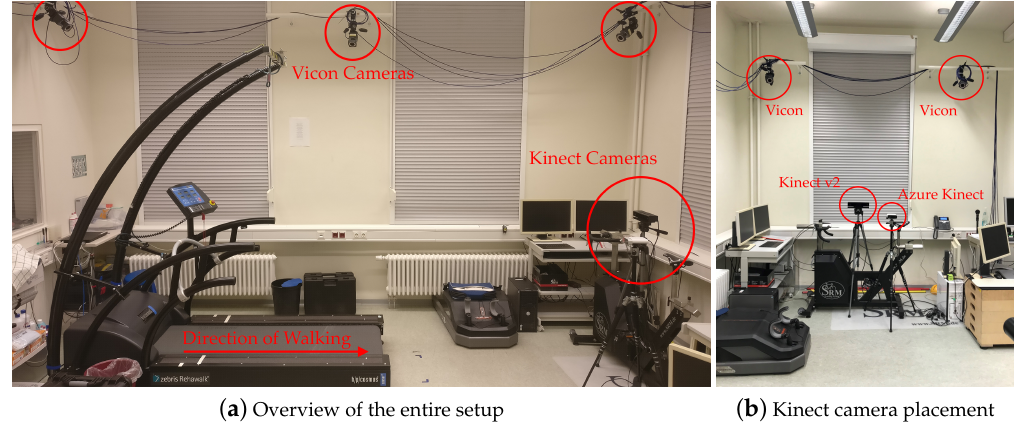
Figure 2. Marker setups for Vicon and both Kinect cameras.